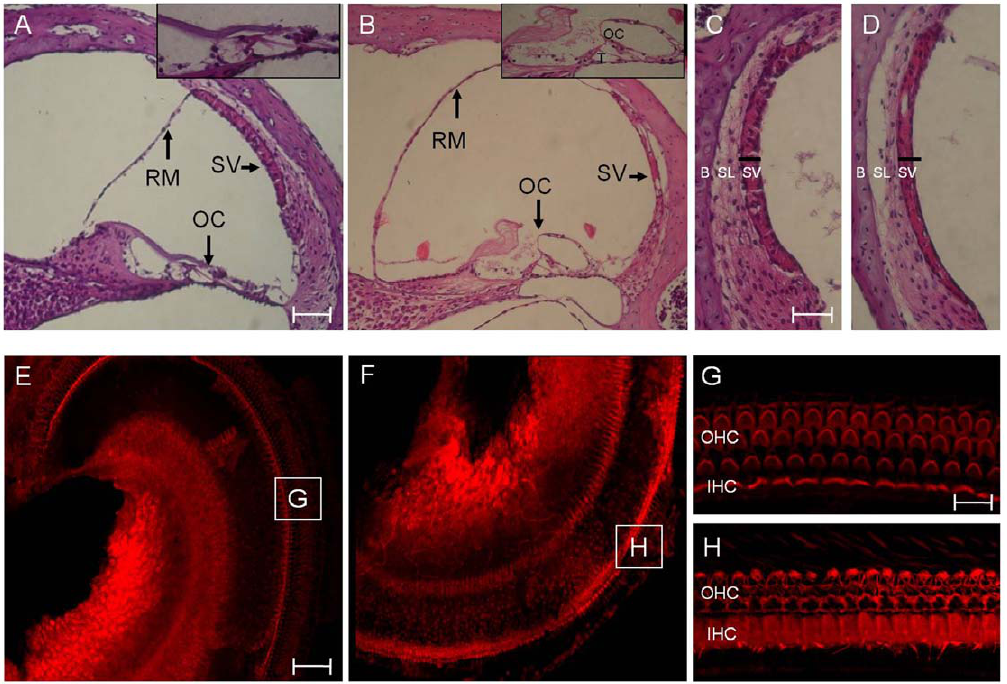
Figure 5. Comparison of cochlear morphology between Slc26a4 + / + mice (A, C, E & G) and Slc26a4 tm1Dontuh/tm1Dontuh mice (B, D, F & H). Microscopic examination of the cochlear duct revealed severe endolymphatic hydrops with dilatation of scala media, degeneration of hair cells (B) and a significant atrophy of the stria vascularis (D) in Slc26a4 tm1Dontuh/tm1Dontuh mice. Degeneration of cochlear hair cells in Slc26a4 tm1Dontuh/tm1Dontuh mice was also revealed by fluorescence confocal microscopy (H). G, H: magnification of boxes G and H from figures E and F, respectively. B, bone; IHC, inner hair cells; OC, organ of Corti; OHC, outer hair cells; RM, Reissner’s membrane; SL, spiral ligament; SV, stria vascularis; T, tunnel of Corti. Bar=150 m m (A & B), 50 m m (C, D, E & F), and 10 m m (G & H).